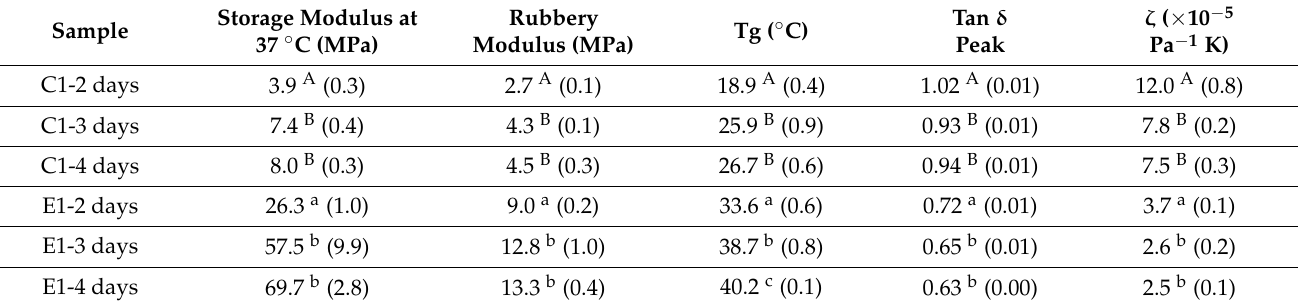
Table 2. Dynamic mechanical analysis results of water-saturated copolymer samples in wet